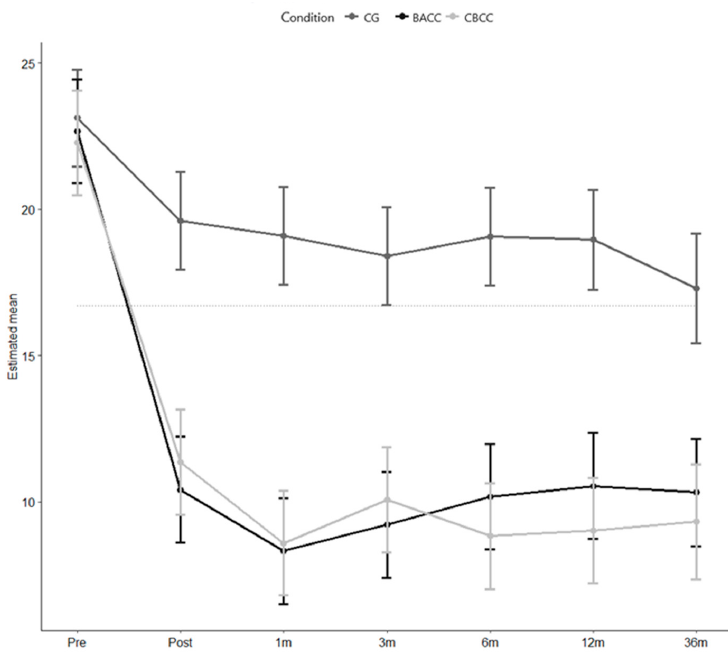
Figure 2. Estimated means at each time point for each Figure 2 . Estimated means at each time point for each group .